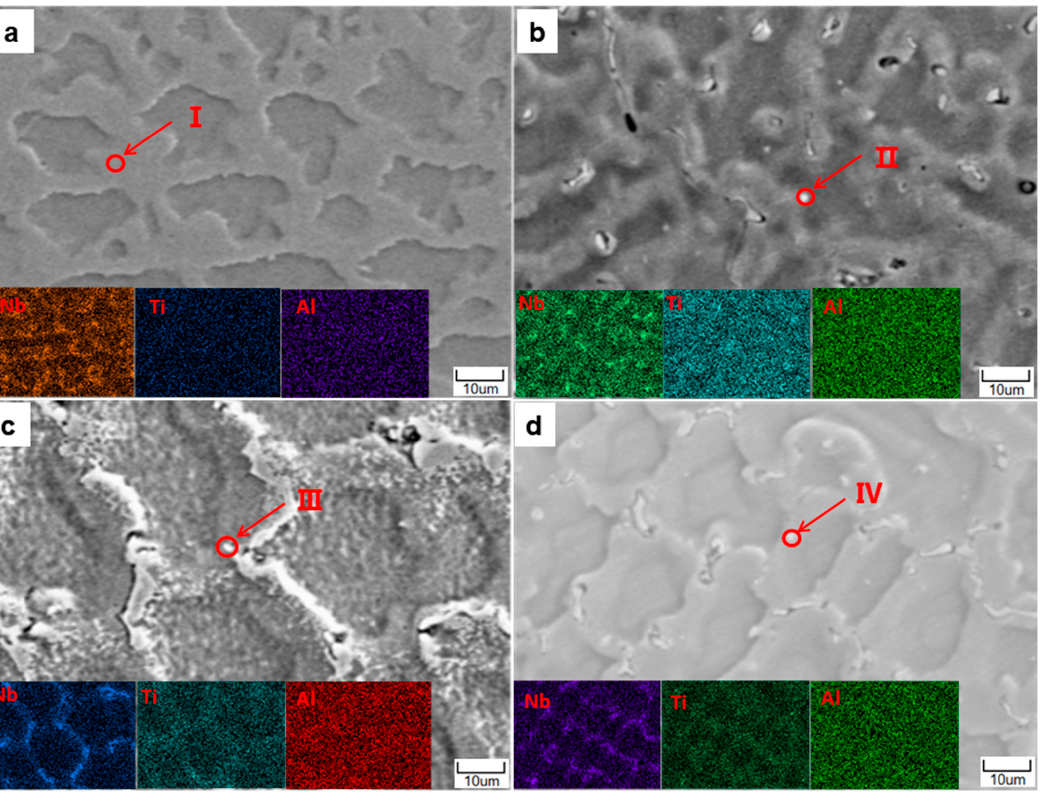
Figure 3. SEM and EDS images of the surface of the coatings without heat treatment (( a ) IN625, ( b ) 1#, ( c ) 2#, ( d ) 3#).